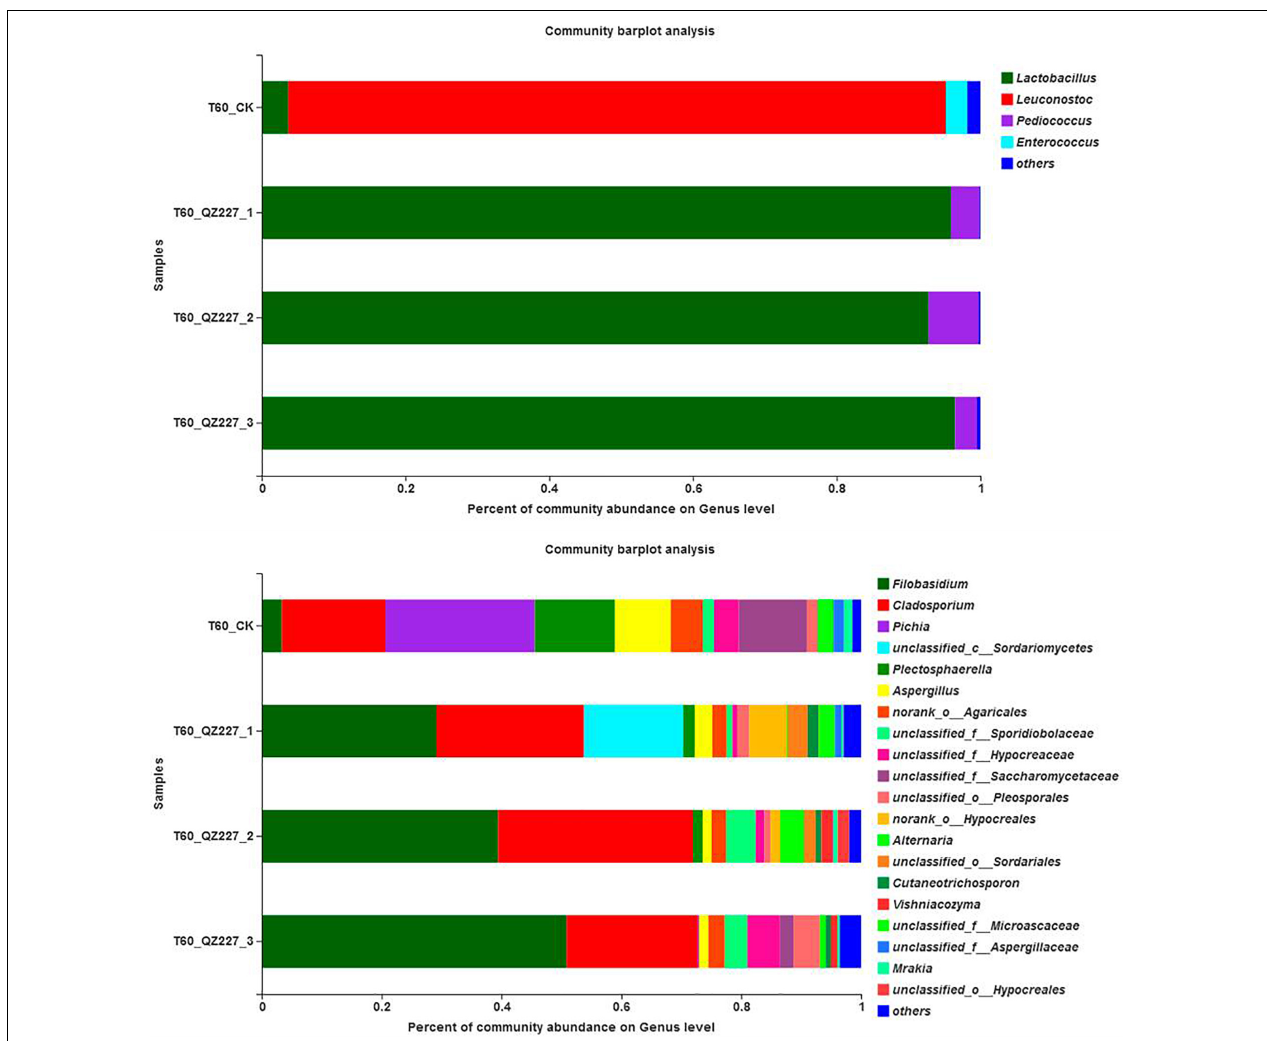
FIGURE 10 | Community abundances of the paralleled QZ227 groups at day